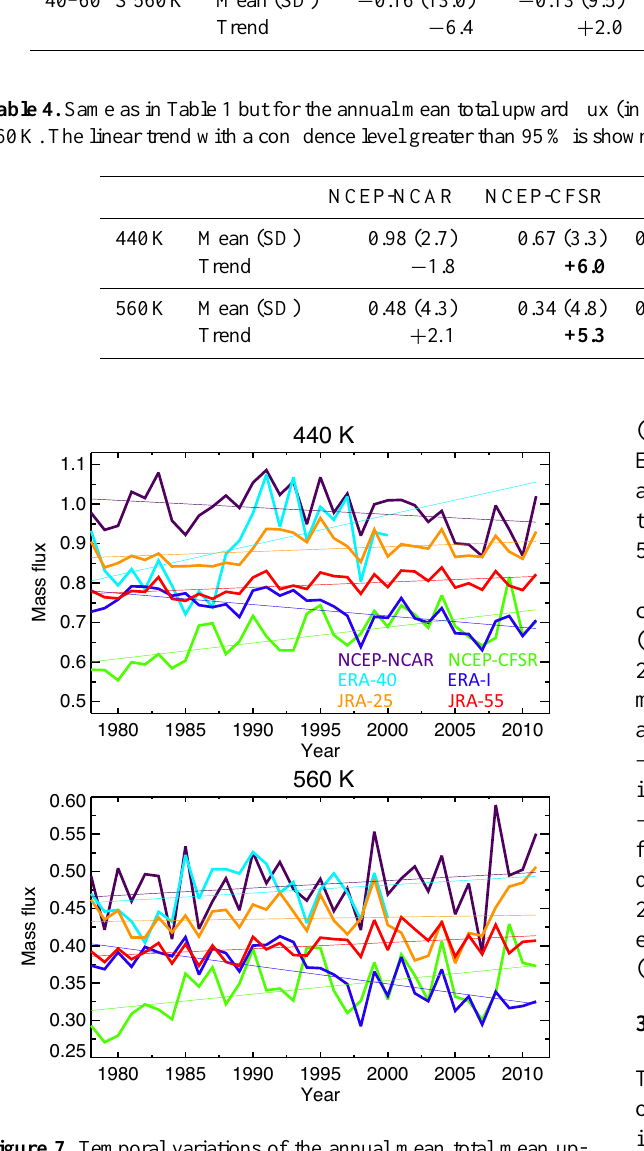
Figure 7. Temporal variations of the annual mean total mean up- ward mass flux (in 10 10 kgs − 1 ) at (top) 440K and (bottom) 560K.